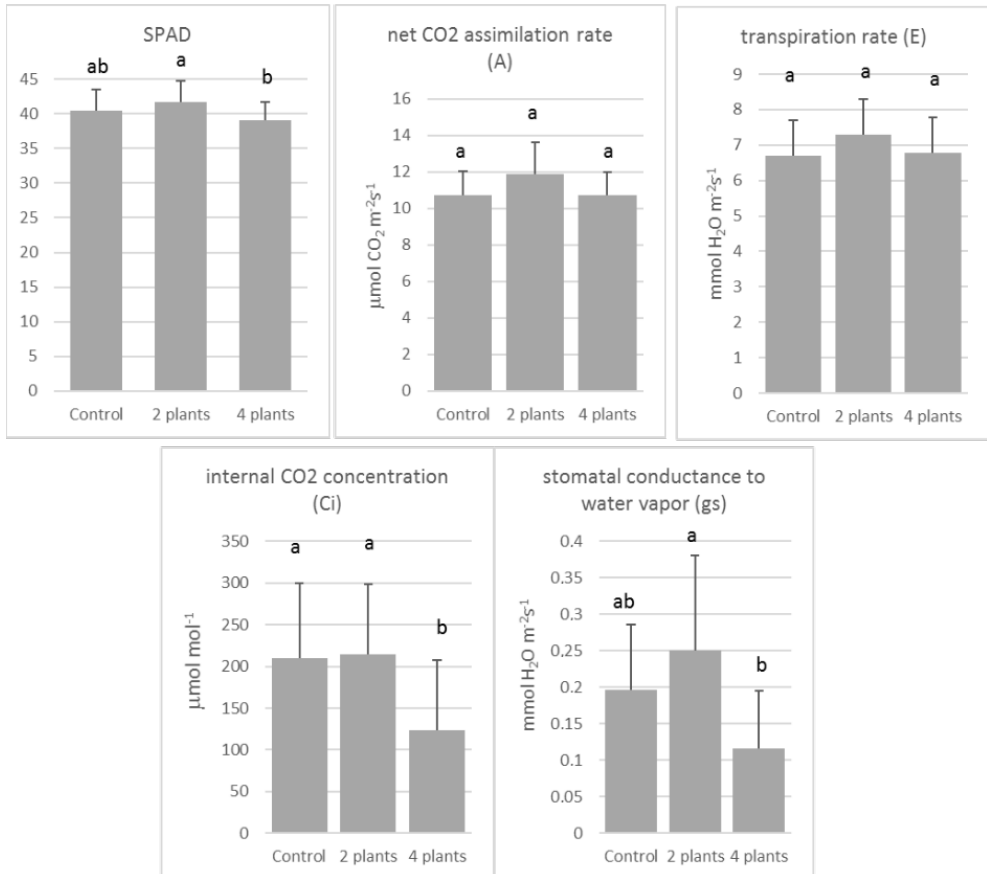
Figure 7. Values of grapevine gas exchange and SPAD unit, measured on 6 August 2019. Different letters represent significant difference from Tukey’s HSD test. Table 1. Weight of vine pruning and grape yield and data from analyses of grape juice at three times during the grape ripening process with mean ± SD. All differences among treatments were not significant for Tukey HSD test.